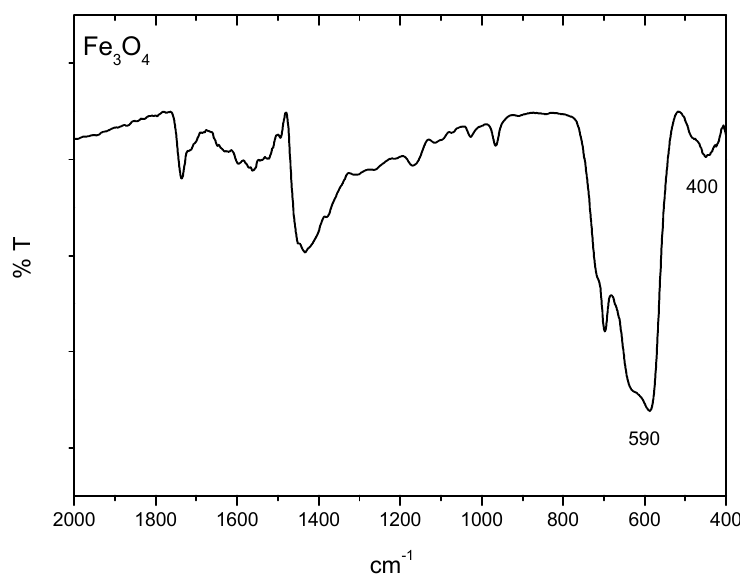
Figure 6. FTIR spectrum of the iron oxide nanoparticle (magnetite) spheres prepared by the hydrothermal method. This analysis was carried out in a JASCO 6200 FTIR (Japan) spectrometer with SPECTRA MANAGER V2 software. The sample was prepared by grinding 1–1.5 mg of dry particles with 150 mg of potassium bromide powder and pressing the mixture with a pellet-forming die. Analysis was done with 50 scans, at a resolution of 4 cm − 1 .